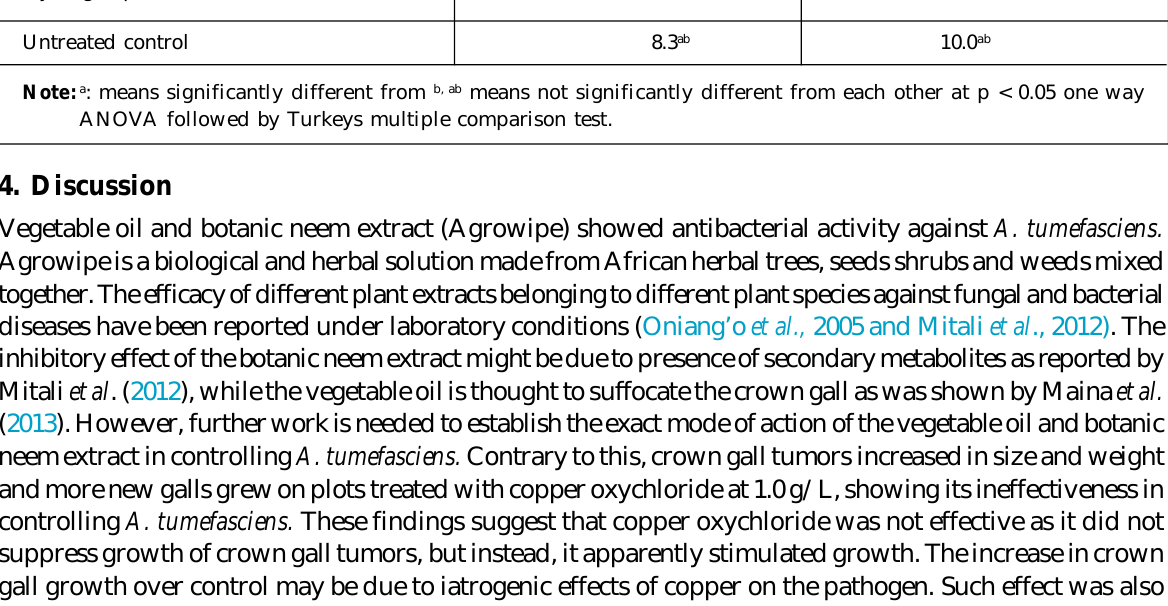
Table 5: Efficacy of Isacop 50 WP (copper oxychloride), fresh fri (vegetable oil), agrowipe (botanic neem extract), dettol (chloroxylenol 4.8%), hydrogen peroxide 50% and untreated control on crown gall tumors rose variety tropical amazone (pooled data for one year pot experiment) Treatment Mean tumor diameter (cm) Mean tumor weight (cm) Isacop 50 WP (copper oxychloride) 1.0 g/L 14.7 a 36.0 a Fresh fri (vegetable oil) – undiluted 3.1 b 1.5 b Agrowipe (botanic neem extract – undiluted 0.9 b Dettol (chloroxylenol 4.8%) 0.5 mL/L Dettol (chloroxylenol 4.8%) 1.0